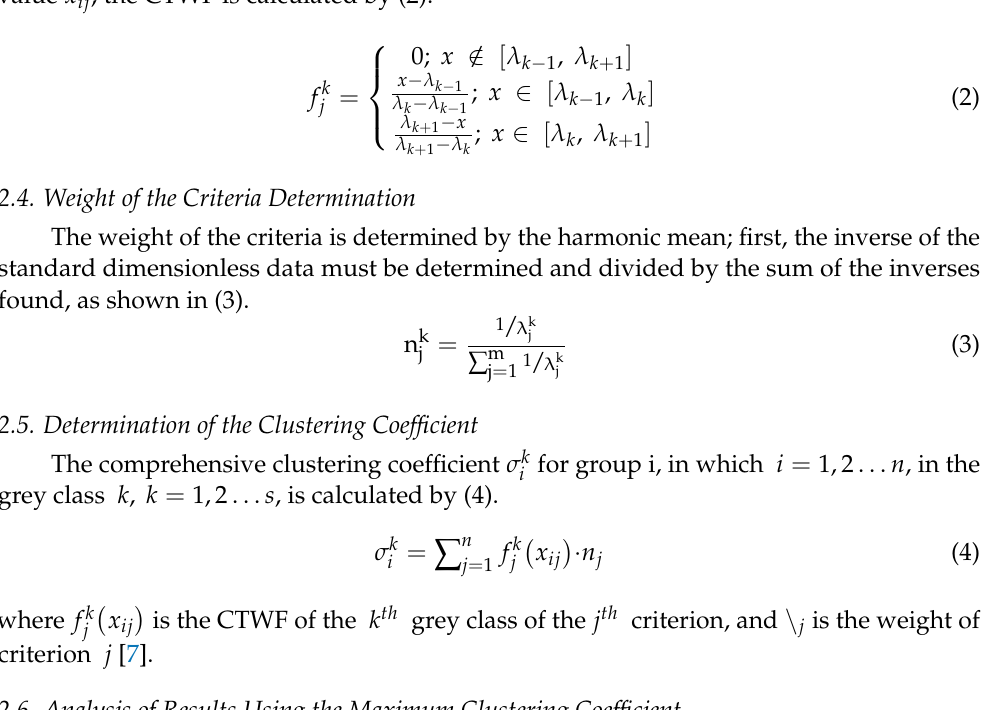
Figure 1. Center-point triangulation based on whitenization functions (CTWF). For the 𝑘 (cid:3047)(cid:3035) grey class, 𝑘 = 1, 2, … , 𝑠, of the 𝑗 (cid:3047)(cid:3035) criterion, 𝑗 = 1, 2, … , 𝑚 , for an ob- served value 𝑥𝑖𝑗 , the CTWF is calculated by (2).